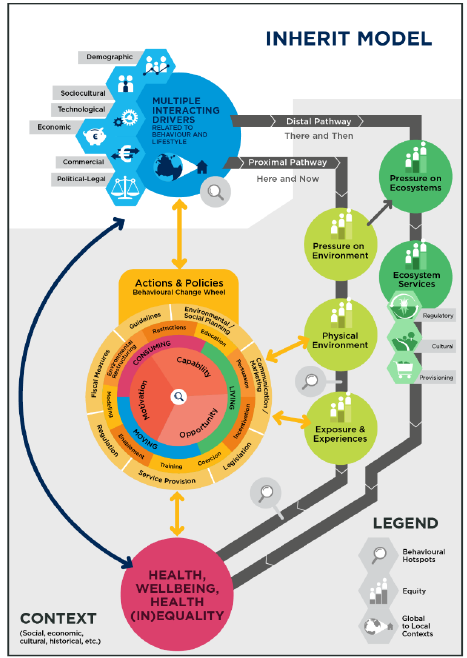
Figure 2. The INHERIT model [31].